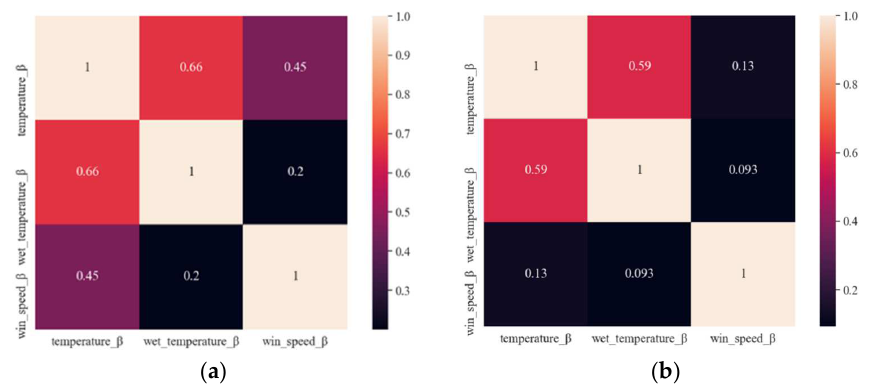
Figure 2. Correlation analysis of β between Beijing ( a ) and Shanghai ( b ).